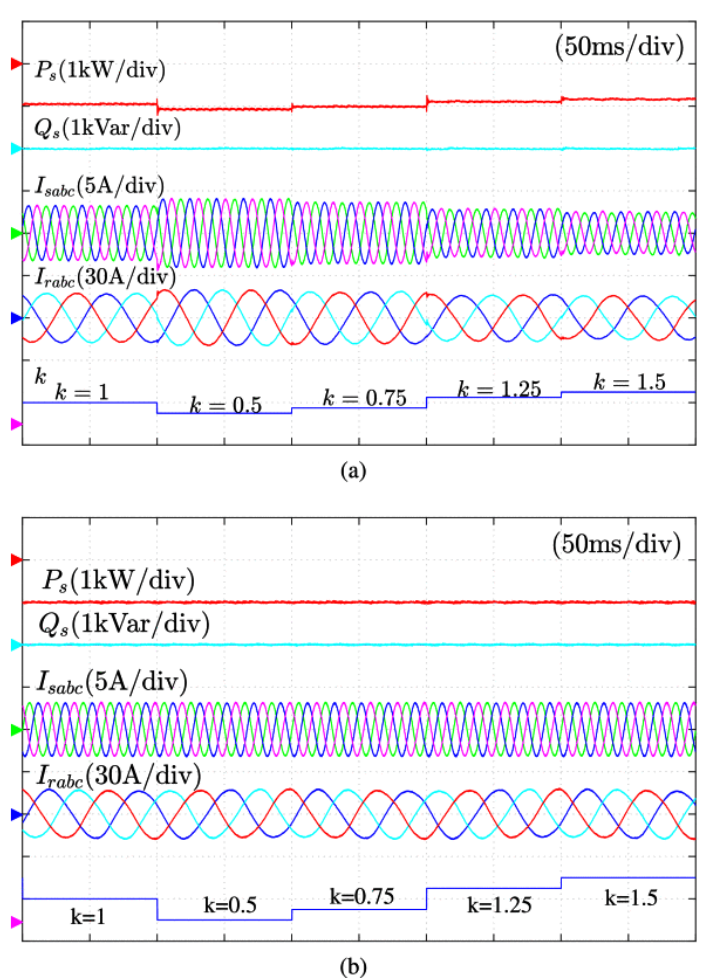
Figure 20. Comparison of two different predictive control methods. ( a ) Model-based predictive control ( b ) Model-free predictive